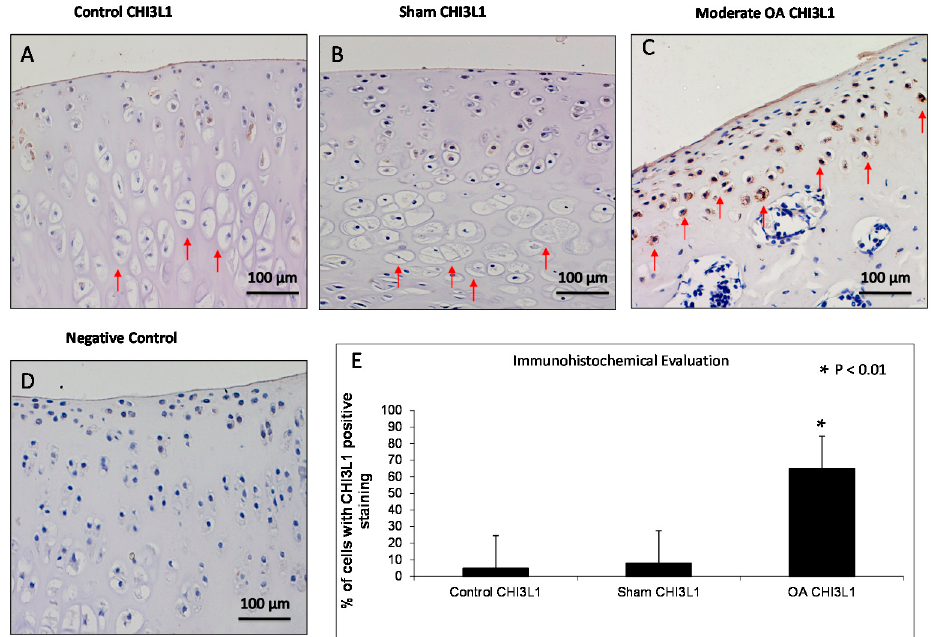
Figure 3. Evaluation of chitinase 3-like-1 (CHI3L1) immunostaining. ( A , B ) CHI3L1 immunohistochemistry specimen from control ( A ) and sham ( B ) rat femoral articular cartilage (without anterior cruciate ligament transection (ACLT)) showed a weak/absent (Extent Score (ES) = +; Intensity immunostaining (IS) = 1) immunostaining in cartilage superficial, middle and deep zone in which hypertrophic chondrocytes are evident (red arrows); ( C ) CHI3L1 immunohistochemistry specimen from moderate OA rat femoral articular cartilage (with ACLT) exhibited a strong (ES = +++; IS = 3) immunostaining in middle and deep cartilage zone (red arrows) and a reduction of cartilage thickness of the superficial and the middle zones is evident and in the deep zone the chondrocytes are not hypertrophic and are not arranged in columns; ( D ) The negative control treated with PBS without the primary antibody (CHI3L1) did not show immunostaining (ES = 0; IS = 0). ( A – D ) Magnifications ×20; Scale bars: 100 µm; ( E ) Immunohistochemical evaluation graph: percentage of CHI3L1 positive cells out of the total number of cells counted in control groups and in OA group. Results are presented as the mean ± SEM. ANOVA was used to evaluate the significance of the results. * p < 0.01, when compared to the control groups.